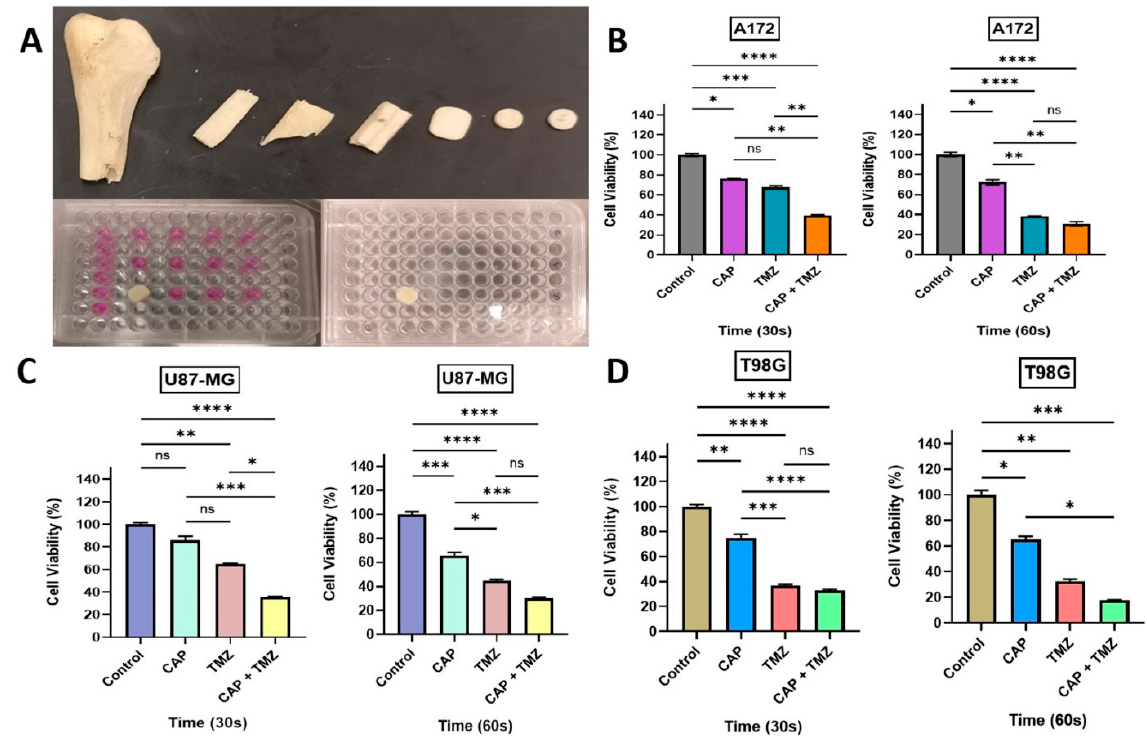
Figure 5. ( A ) Picture of a human bone fibula sectioned into smaller pieces to fit 96-well flat-bottom plates. Relative growth viability (%) of A172 ( B ) U87-MG ( C ), and T98G ( D ) cells 72 h after 30 or 60 s CAP treatment with or without TMZ co-treatment. All of the cell lines were treated without media, and a bone section was placed on top of the wells. The treatment groups for each cell line were normalized to their relative untreated controls (0 s). A one-way ANOVA was performed with Tukey’s multiple comparison post hoc test. * p < 0.05; ** p < 0.01; *** p < 0.001; and **** p < 0.0001, ns—not significant vs. untreated control. n =